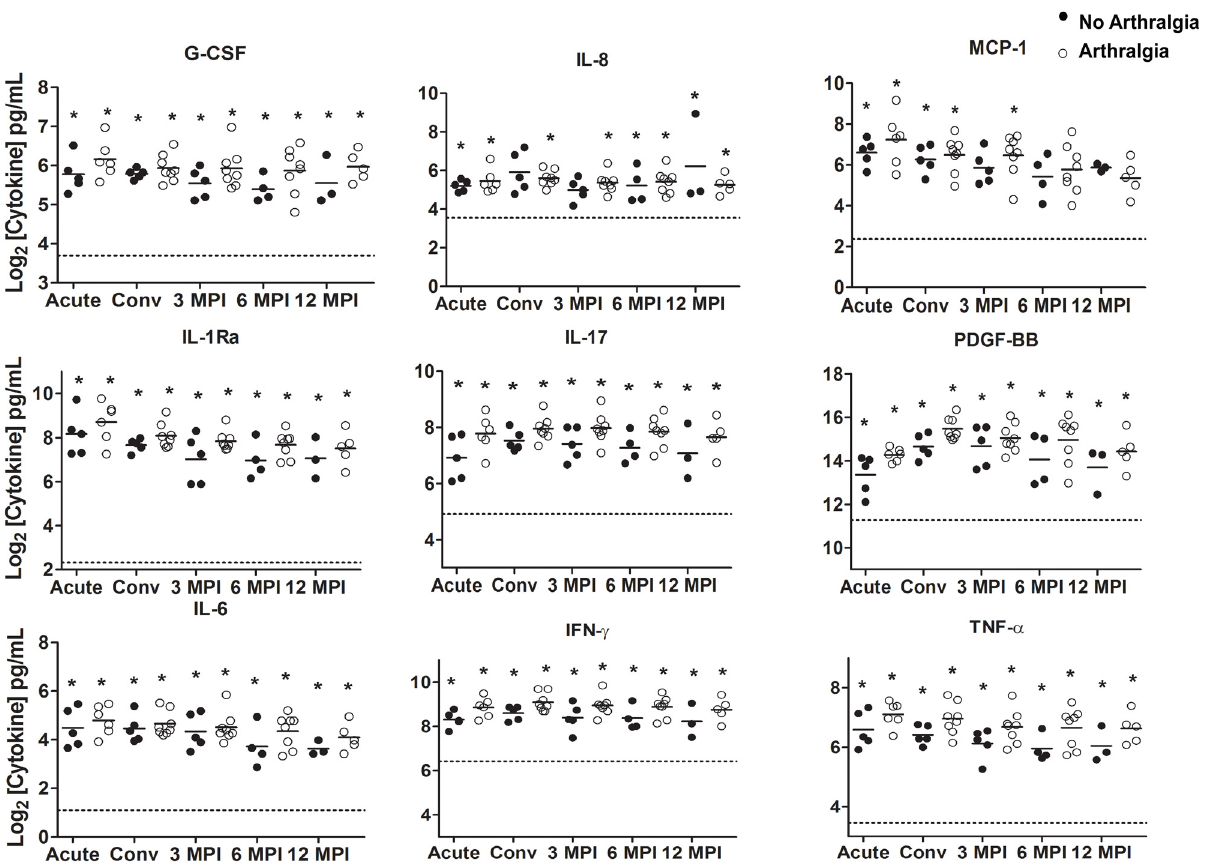
Fig 3. Induction of cytokine/chemokine immune mediators in MAYV-infected subjects with or without persistent arthralgia. Serum samples were collected at the acute visit as well as the convalescent visit (20 ± 10 days), at 90 ± 10 days, at 180 ± 15 days, and at 360 ± 30 days after the acute visit. The serum concentrations of a variety of cytokines were assessed by a cytokine bead array. The cytokine concentrations in subjects with (open circles) or without (closed circles) persistent arthralgia were compared to healthy donor controls by a 2-tailed Mann-Whitney test. An asterisk ( * ) indicates statistical significance (p < 0.05) when compared to healthy controls. Comparisons between MAYV infected groups were also performed by a 2-tailed Mann-Whitney test. No statistical significance (p < 0.05) between the MAYV infected groups was found. The horizontal dotted line represents the median cytokine values for the healthy donor controls. Each circle corresponds to the cytokine concentration of an individual subject and the solid horizontal line represents the mean cytokine concentration of the group.